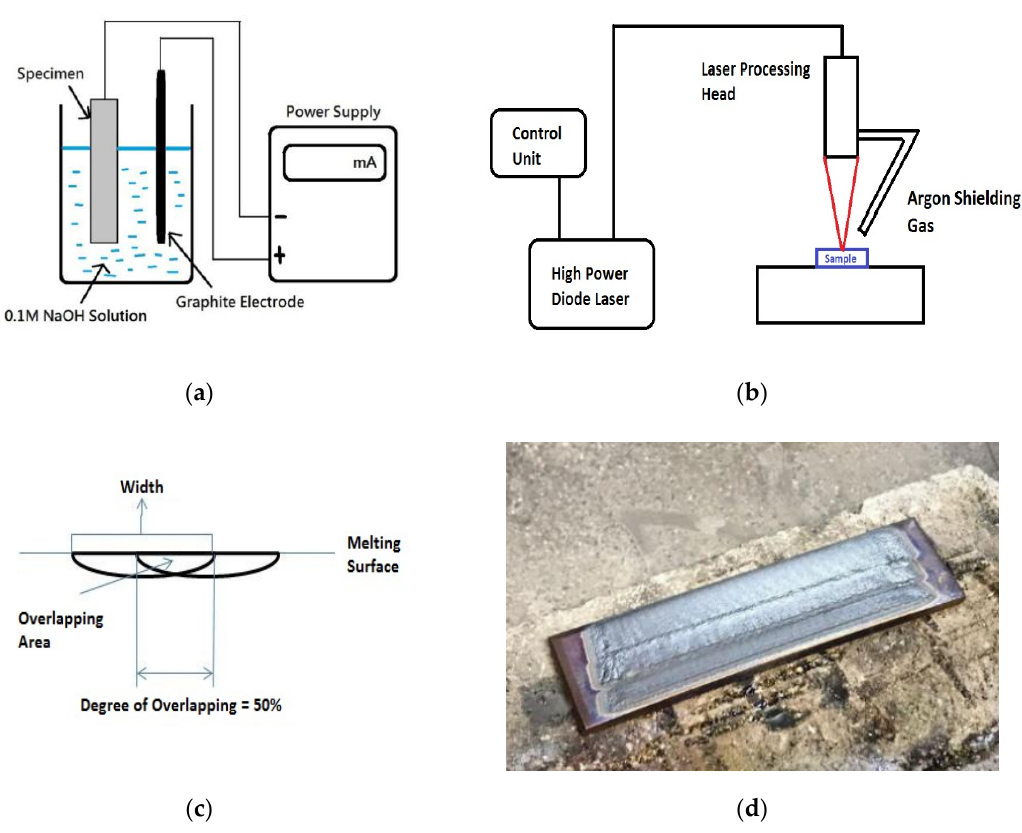
Figure 1. Schematic diagrams of ( a ) setup of hydrogen pre-charging of AISI 430 steel, ( b ) setup of laser surface melting (LSM) of AISI 430 steel, ( c ) overlapping of successive tracks by LSM, and ( d ) sample fabricated by LSM for hydrogen pre-charging and tensile testing.